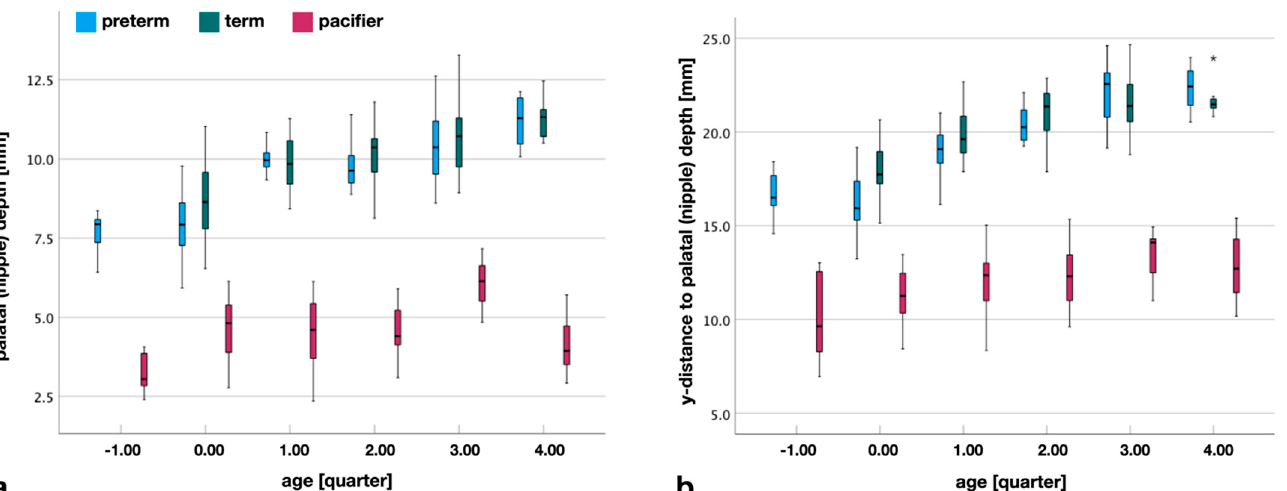
Figure 4. Midline submental ultrasound image of an infant’s oral cavity during non-nutritive sucking. The tongue is in a superior position and the maternal nipple rests at the deepest curvature of the hard palate (area of palatal depth). When nutritive sucks are performed, the nipple increases in volume and reaches up to 2.7 ± 1.0 mm to the hard-soft palate junction (HSPJ). The palatal depth ( pd) is the distance in the vertical (z-) direction between ARP and the uppermost point of the palatal vault. This distance increases with age and is observed in both preterm and term infants. This increase is not observed in the design of the pacifiers.